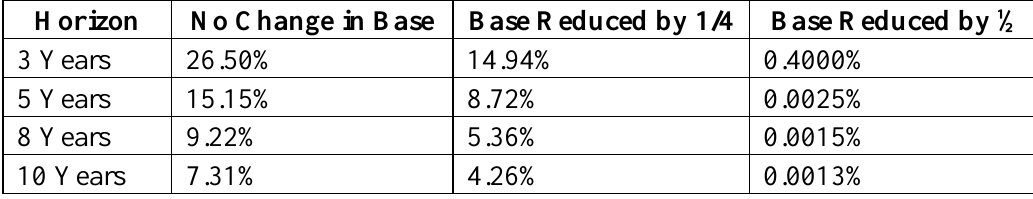
Table 9. Annualized Growth Rates for M1 Given Assumptions for Growth Rates in the Multiplier as Presented in Table 7 1